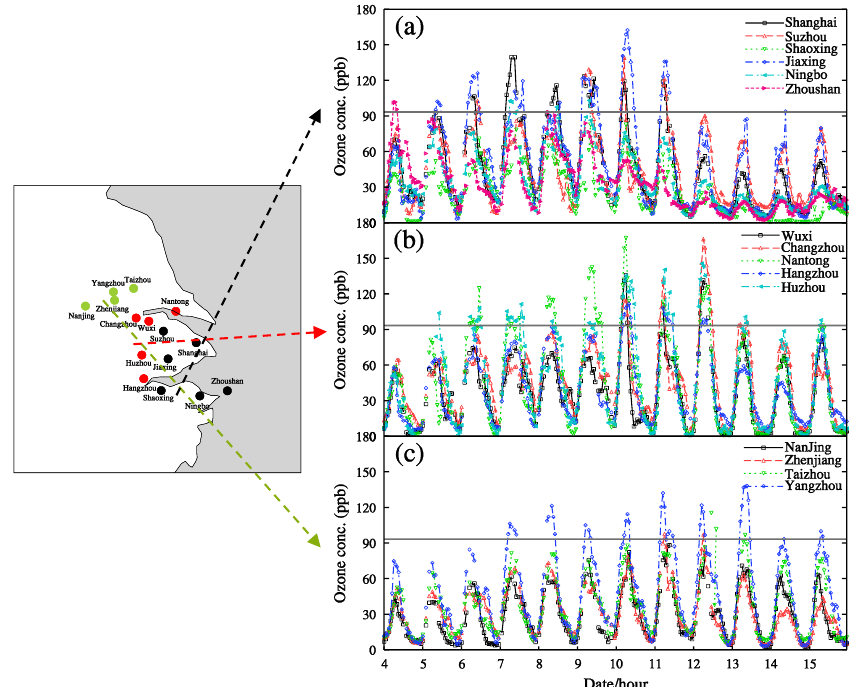
Figure 2. The time series of the observed O 3 concentrations in 15 typical cities from 4 to 15 August 2013 over the YRD region, which can be divided into three areas: (a) the Southeast Coast Region (SCR), including Shanghai, Suzhou, Shaoxing, Jiaxing, Ningbo and Zhoushan; (b) the Central Inland Region (CIR), including Wuxi, Changzhou, Nantong, Hangzhou and Huzhou; (c) the Northwest Inland Region (NIR), including Nanjing, Zhenjiang, Taizhou and Yangzhou. The gray solid lines in (a) , (b) and (c) represent the national standard for the hourly O 3 concentration, which is 200µgm − 3